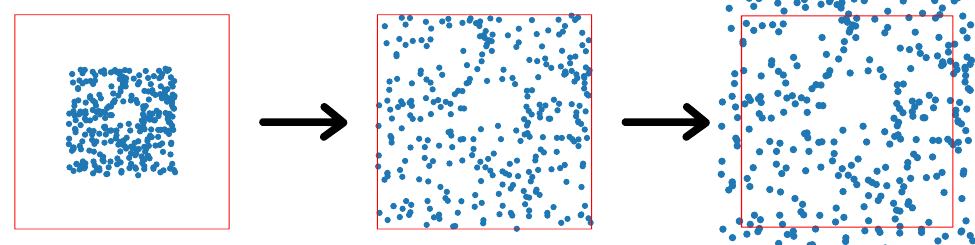
Figure 1. Numerical experiments for the uncertainty sets.